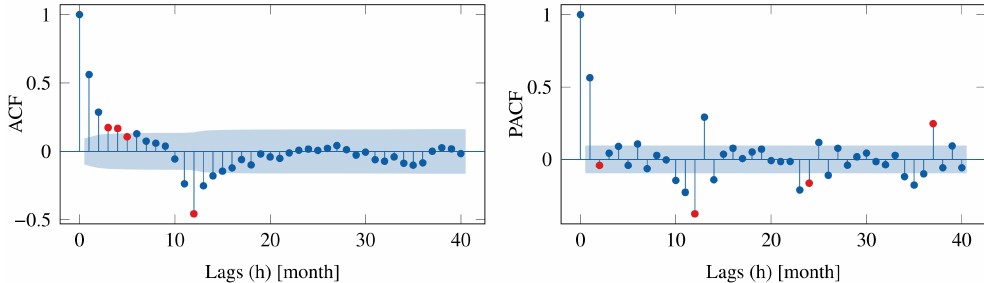
Figure 11. The ACF and PACF of the seasonally differenced SIC series in sub-region No. 2. The blue shaded regions represent the range of zero plus/minus two standard errors. When values fall within the shaded region, the ACF and PACF are considered to be zero. The lags of the red dots provide information to determine the orders of the ARIMA model.